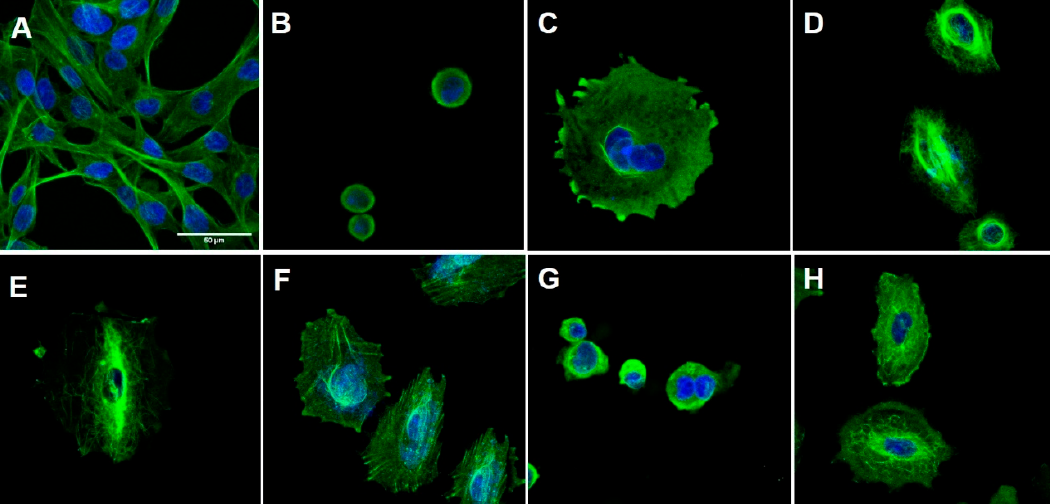
Figure 4. Immunofluorescence of H1975 cells. The cells were stained with an antibody against β -tubulin (green) and with DAPI (blue), viewed with a 63-fold objective, maintained with or without treatment for 48 h. ( A ) Negative control cells (DMSO 0,1%); ( B ) cells treated with CA-4 ( 1 , 0.3 µ M); ( C ) cells treated with vincristine (0.5 µ M); ( D ) cells treated with taxol (0.1 µ M); ( E ) cells treated with LASSBio-1586 ( 2 , 10 µ M); ( F ) cells treated with LASSBio-1735 ( 3 , 0.5 µ M); ( G ) cells treated with LASSBio-2070 ( 10 , 4.5 µ M); ( H ) cells treated with LASSBio-2074 ( 11 , 20 µ M). The data were obtained by at least two independent experiments performed in triplicate.